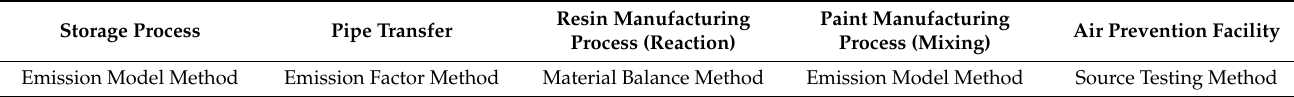
Table 3. PRTR calculation technique applied to each process in a paint plant.